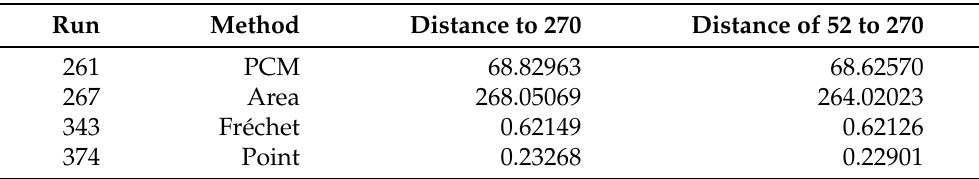
Table 3. Distance values for the four implemented distance metrics for the runs in the selected test set, compared to the reference run 270.